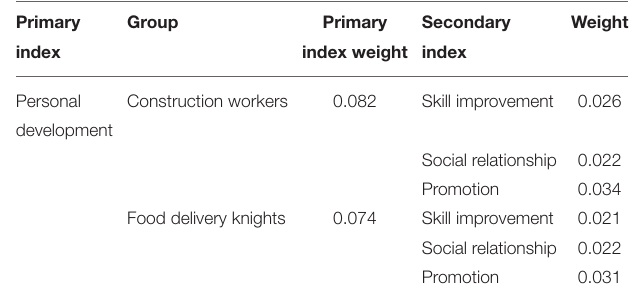
TABLE 8 | Kolmogorov–Smirnov test results of the index “psychological needs”.